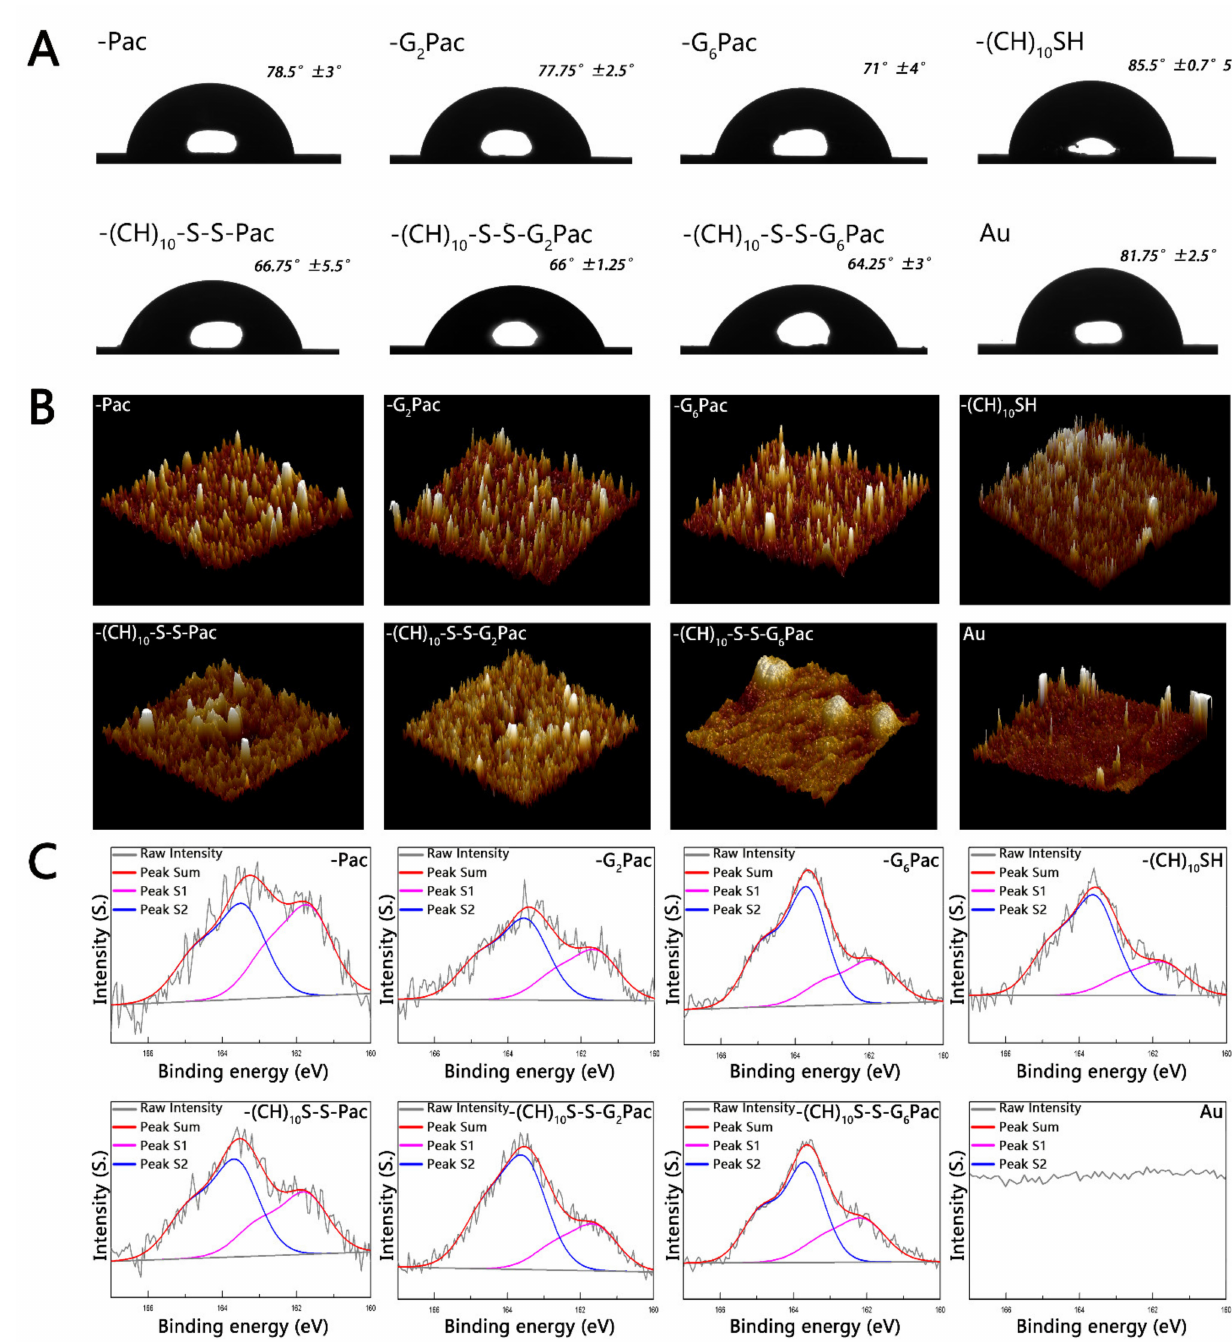
Figure 2. Surface characterization of the AMP-functionalized substrates. ( A ) The water contact angles measurement; ( B ) AFM images; ( C ) XPS spectra